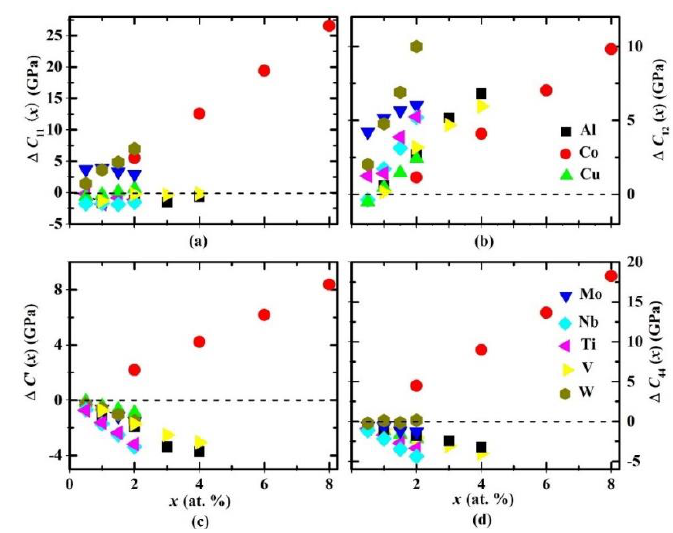
Figure 3. Theoretical changes in single-crystal elastic constants ( a ) ∆ C 11 ( x ), ( b ) ∆ C 12 ( x ), ( c ) ∆ C ’( x ), and ( d ) ∆ C 44 ( x ) of paramagnetic fcc Fe 0.6− x Cr 0.2 Ni 0.2 M x (M = Al, Co, Cu, Mo, Nb, Ti, V, and W; 0 ≤ 𝑥 ≤ 0.08 ) quaternary alloys relative to the paramagnetic fcc Fe 0.6 Cr 0.2 Ni 0.2 ternary alloy as a function of atomic concentration x . Table 2. Theoretical (EMTO) single-crystal elastic constants (in GPa) for paramagnetic fcc Fe–20Cr– 20Ni– x %M (M = Al, Co, Cu, Mo, Nb, Ti, V, and W; 0 ≤ 𝑥 ≤ 8 , where x is in atom %) alloys calculated at their lattice parameter a exp (in Å ) estimated from Equation (7).